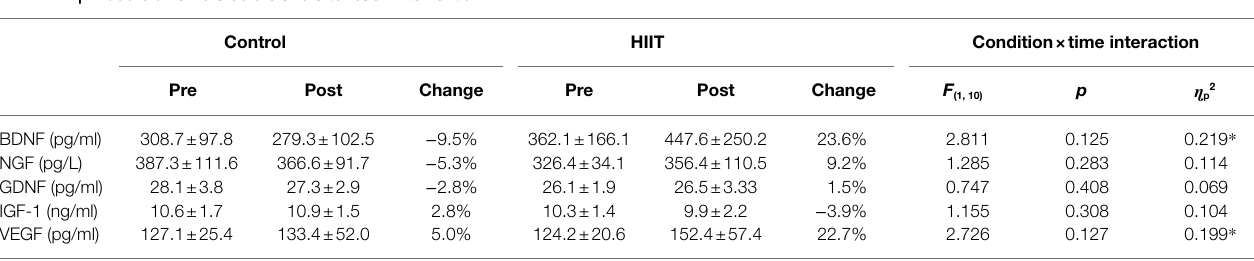
TABLE 2 | Blood biomarkers before and after each intervention. Control HIIT Condition × time interaction Pre Post